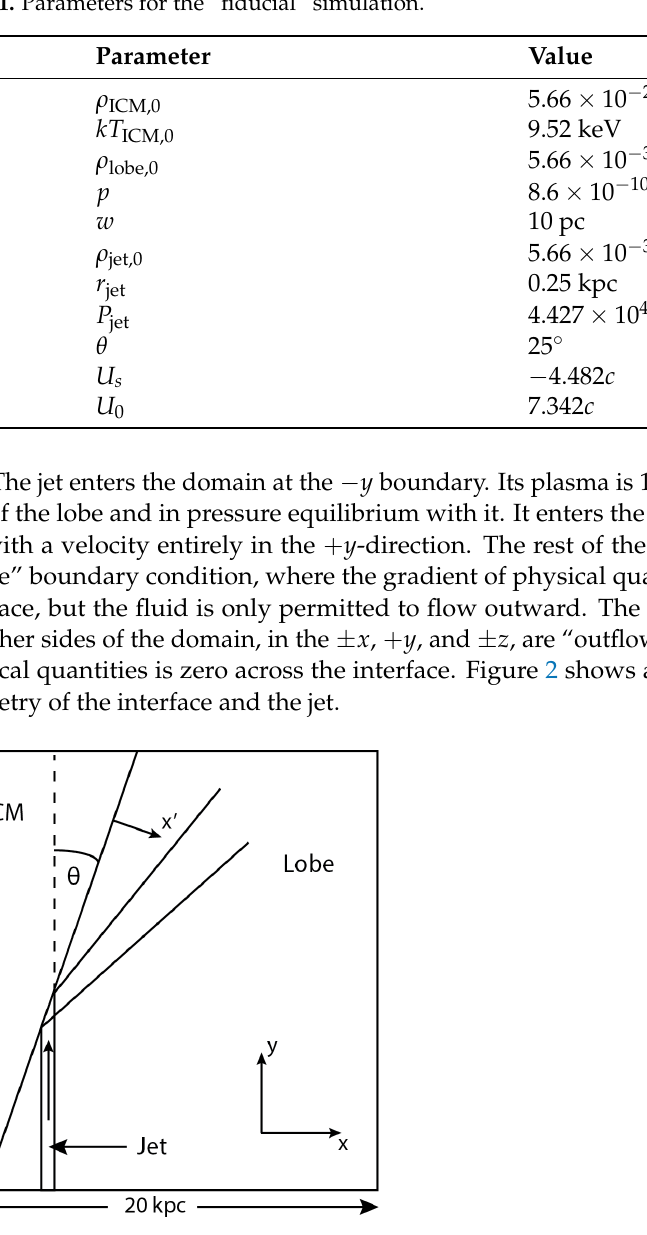
Figure 2. Schematic of the simulation setup, showing the ICM and lobe regions divided by a sharp interface tilted with respect to the coordinate axes, along with the trajectory of the